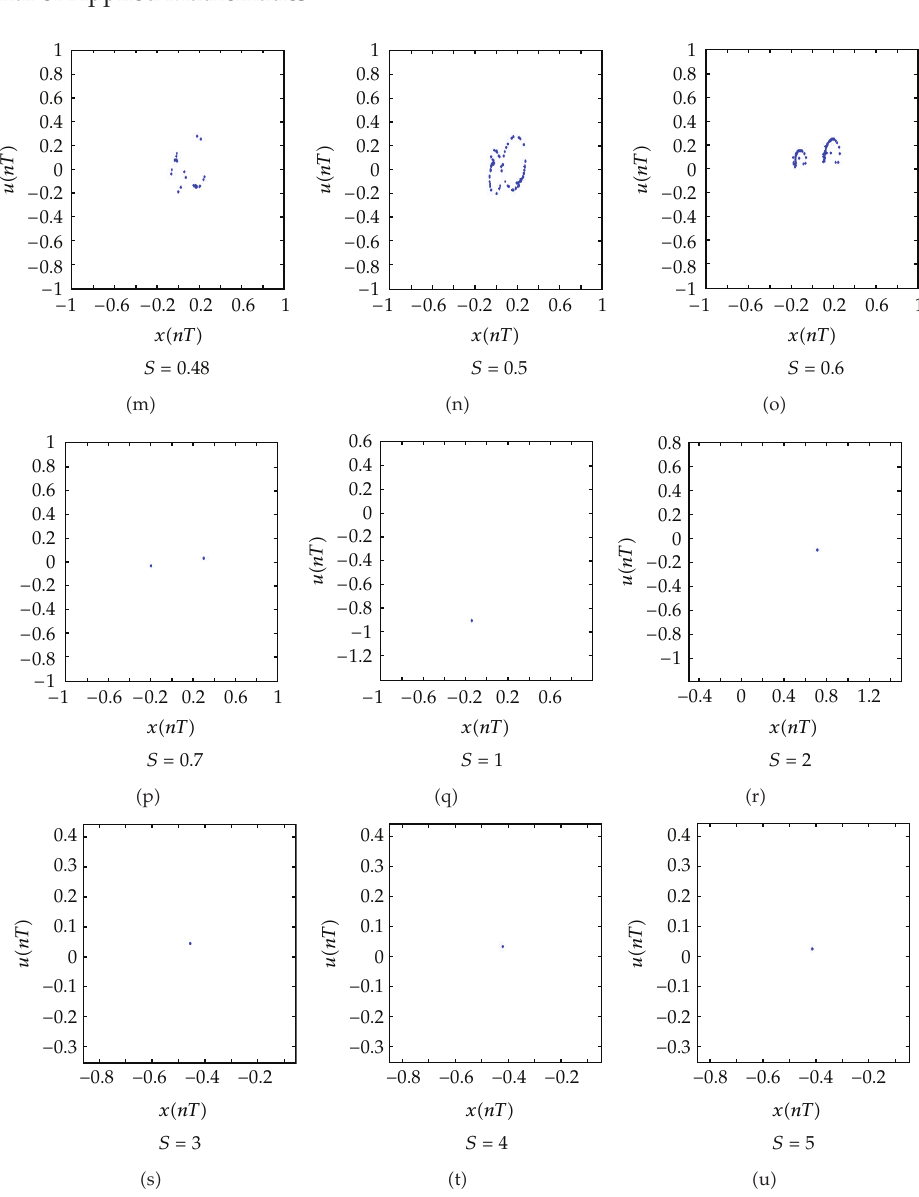
that HSFD mounted rotor-bearing system with rub-impact force e ff ect present nonperiodic motions at low rotating speeds and perform periodic motions at high rotating speeds. The results will enable suitable values of the rotating speed ratio to be specified such that chaotic behavior can be avoided, thus reducing the amplitude of the vibration within the system and extending the system